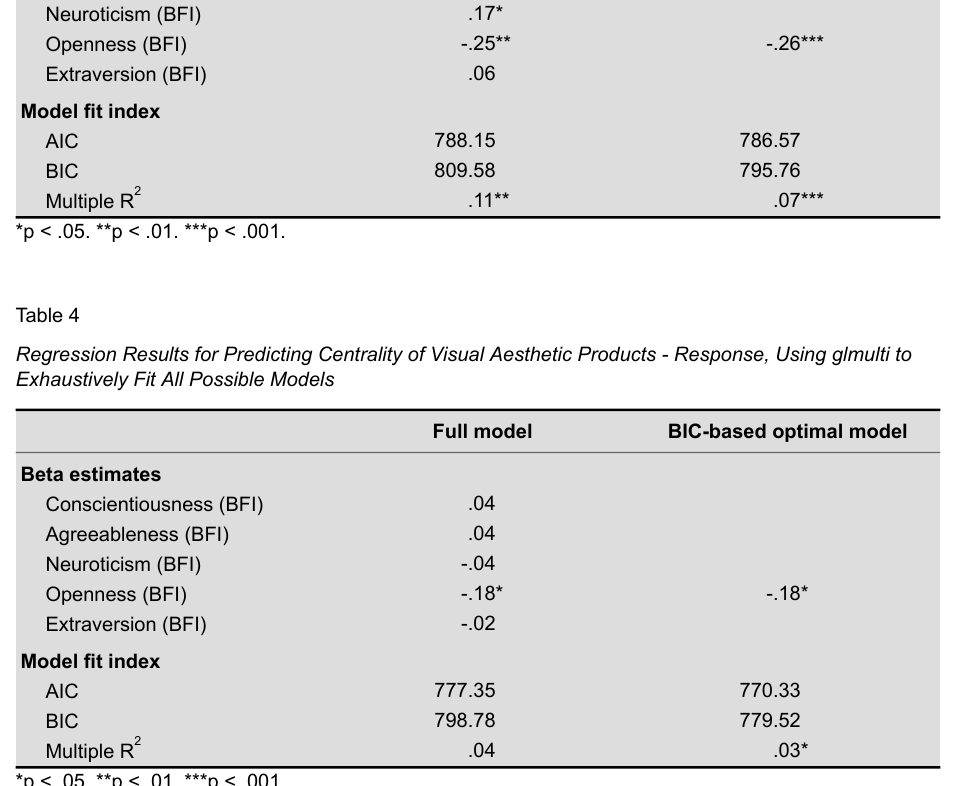
BIC-based optimal modelFull model